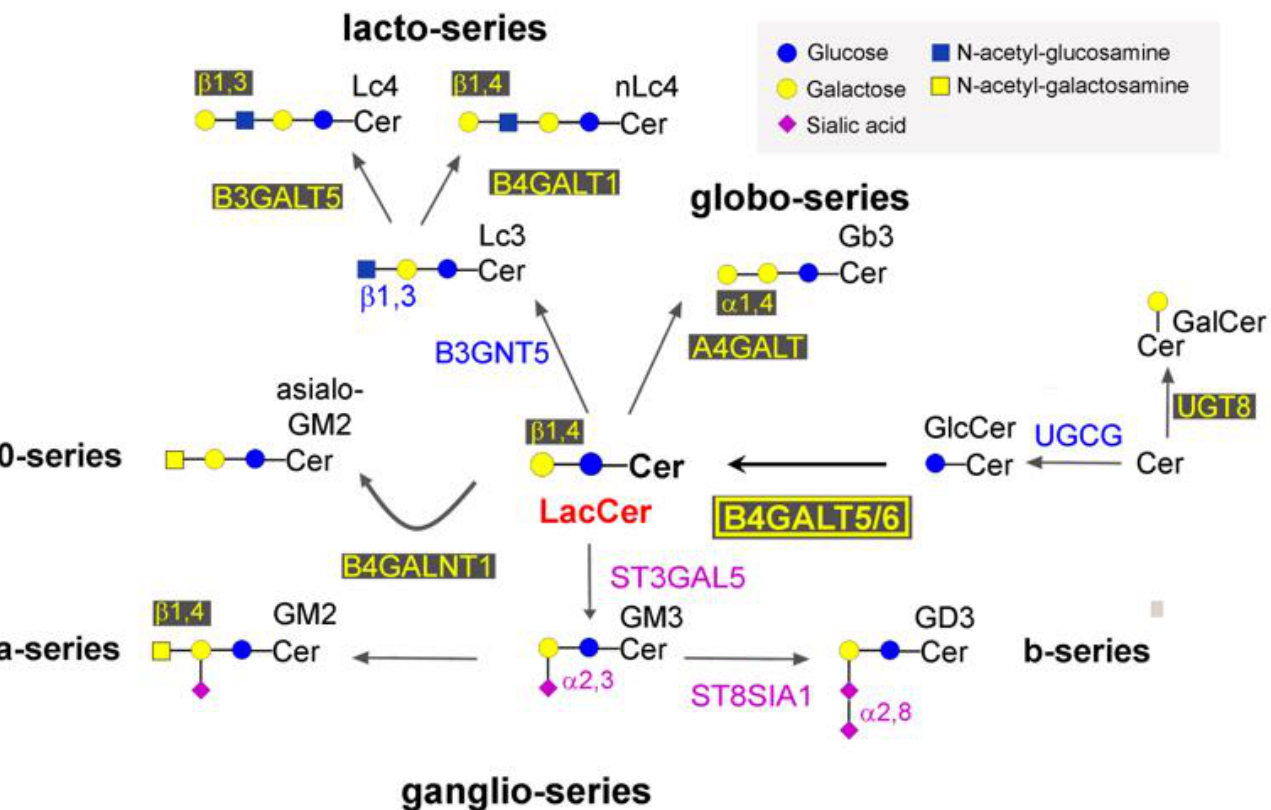
Figure 1. Biosynthesis of the major classes of glycosphingolipids. Monosaccharides are depicted according to the current representation. Anomers, linkage positions, and enzymes involved in the reactions are indicated. Glycosyltransferases are named according to the HUGO recommendations.